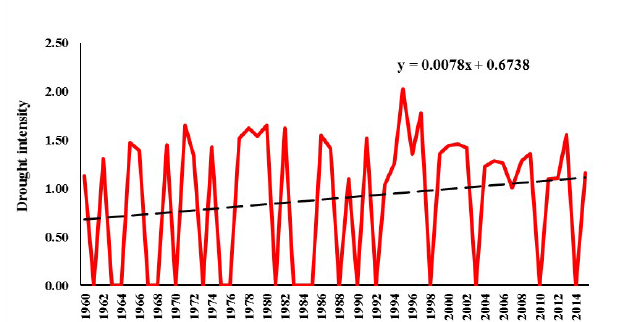
Table 3. Classification of drought calculated by the VHI.